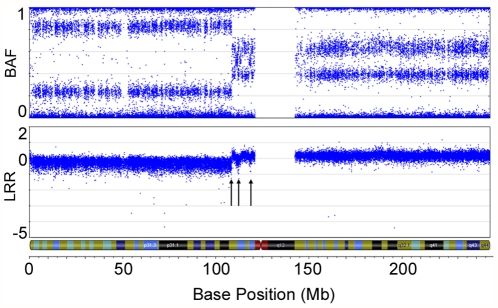
Example of intrachromosomal breaks and allelic imbalance in an LMP tumour.SNP array imaging results for chr1 of LMP sample TOV-845T. Several intrachromosomal breaks are denoted by arrows on 1p, and are visualized by breaks in the continuity of both the B allele frequency and Log R ratio plots. Note the Log R ratio indicates loss of copy number for most of the 1p arm, with gains of copy number near the centromere. The double row in the BAF plot observed on 1q indicates allelic imbalance of SNP markers across the entire chromosomal arm. Note the Log R ratio for the 1q arm averages above 0, indicating a gain of copy number.